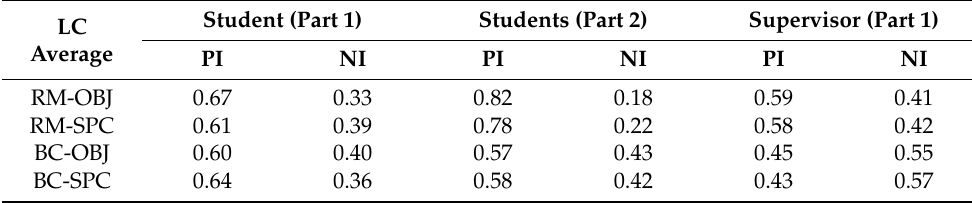
Table 5. Positive and Negative Index for LC Project (Part 1 and